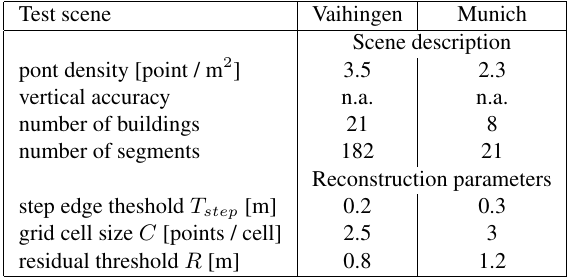
Table 1. Characteristics of the two test scenes and applied param- eters for testing the proposed method.